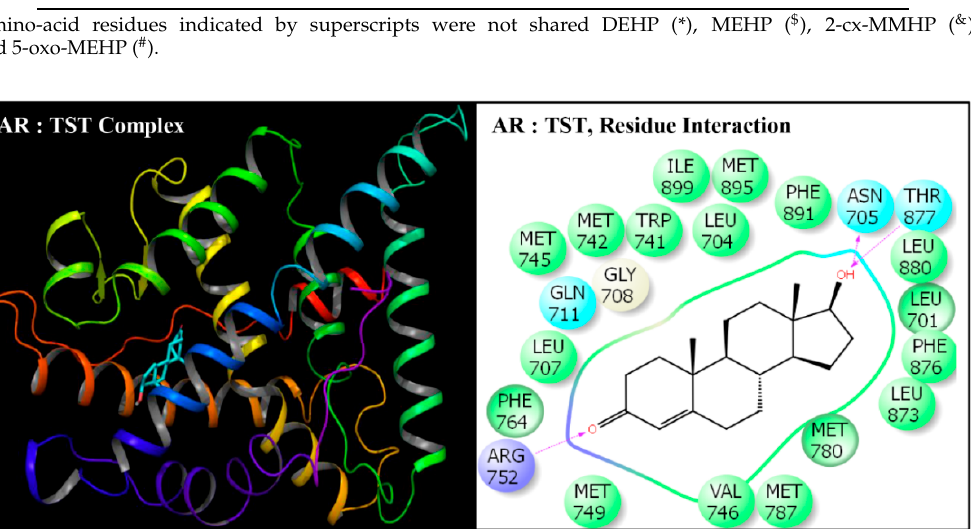
Figure 8. Ribbon diagram representing the docking pose of human androgen receptor (AR) with native ligand testosterone (TST) (left panel). The interactions of ligand (TST) with amino-acid residues in the binding pocket of AR (right panel).